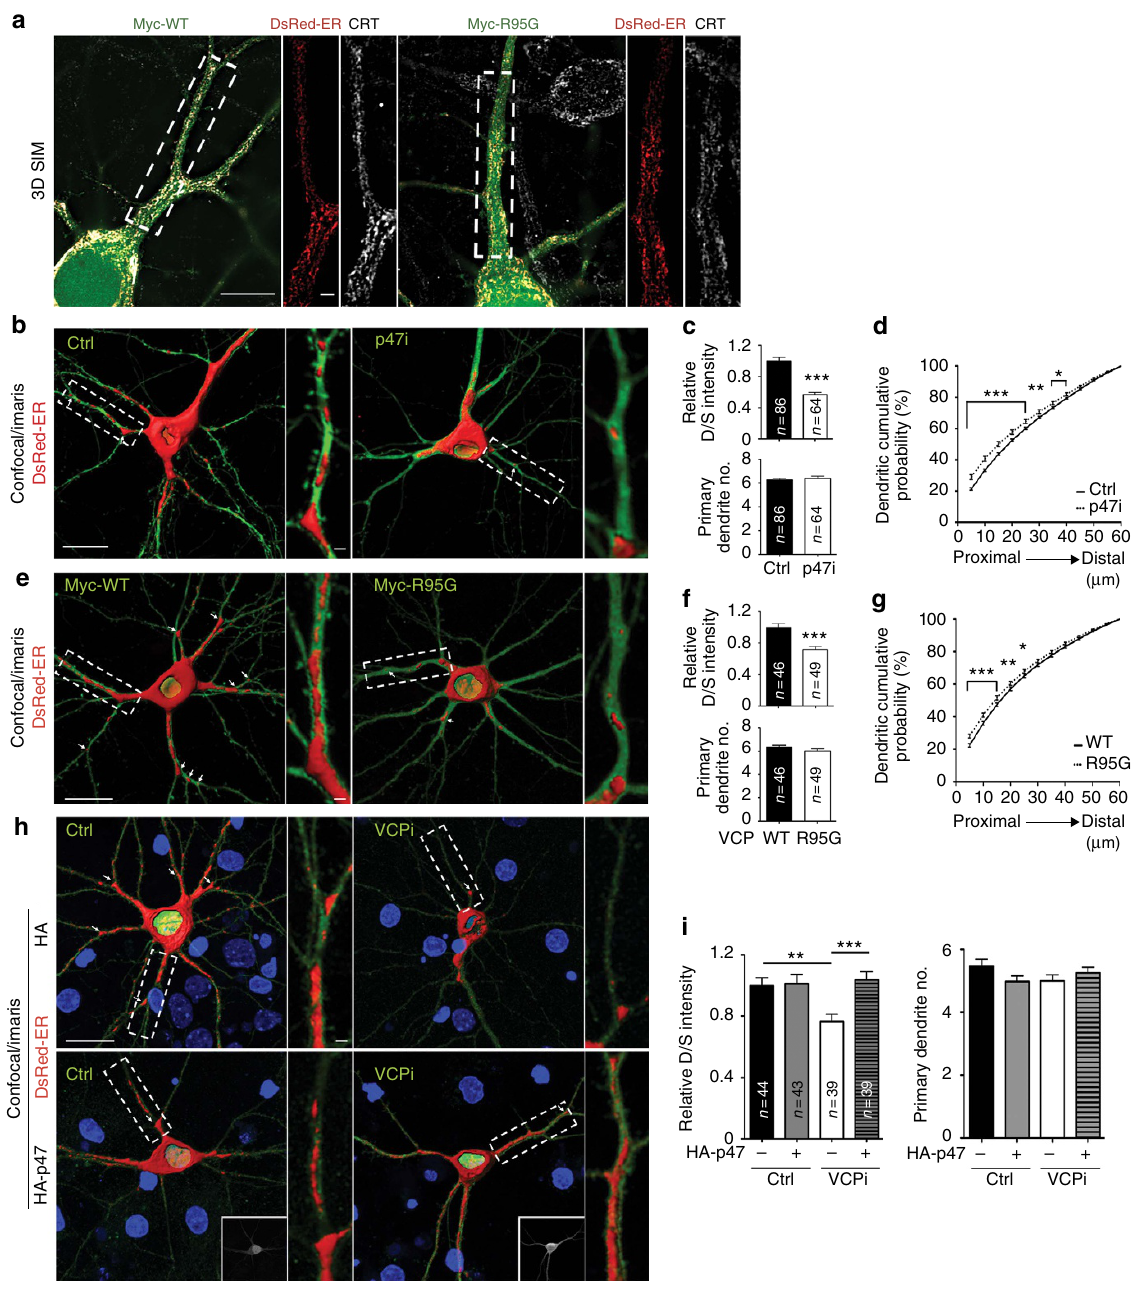
Figure 2 | VCP and P47 regulate dendritic ER distribution. ( a ) 3D SIM images of cultured hippocampal neurons. DsRed-ER and Myc-tagged WT Vcp or the R95G mutant were cotransfected into neurons at 12 DIV and analyzed with immunostaining using Myc, DsRed and the endogenous ER marker calreticulin (CRT) antibodies at 18 DIV. ( b – i ) DsRed-ER was cotransfected with the indicated plasmids into cultured neurons. The Z-series of the confocal images were processed with the Surpass Mode of the Imaris software (Bitplane) as shown in ( b , e , h ). Arrows identify the examples of the dendritic branch sites with enriched ER. ( c , f , i ) The ratio of dendritic DsRed to somatic DsRed (D/S) and the total number of dendrites. ( d , g ) The cumulative probability of dendritic DsRed-ER shows the accumulation of DsRed-ER in the proximal region of the dendrites in P47i- and R95G-expressing cells. Ctrl, non-silencing control. Scale bars: ( a ) original, 10 m m; enlarged, 2 m m; ( b , e , h ) original, 20 m m; enlarged, 2 m m. The data are from three independent experiments and are presented as the mean plus s.e.m. (error bars). The sample sizes ( n ) of the examined neurons are indicated. * P o 0.05; ** P o 0.01; *** P o 0.001. Unpaired t -test ( c , f ); two-way ANOVA ( d , g , i